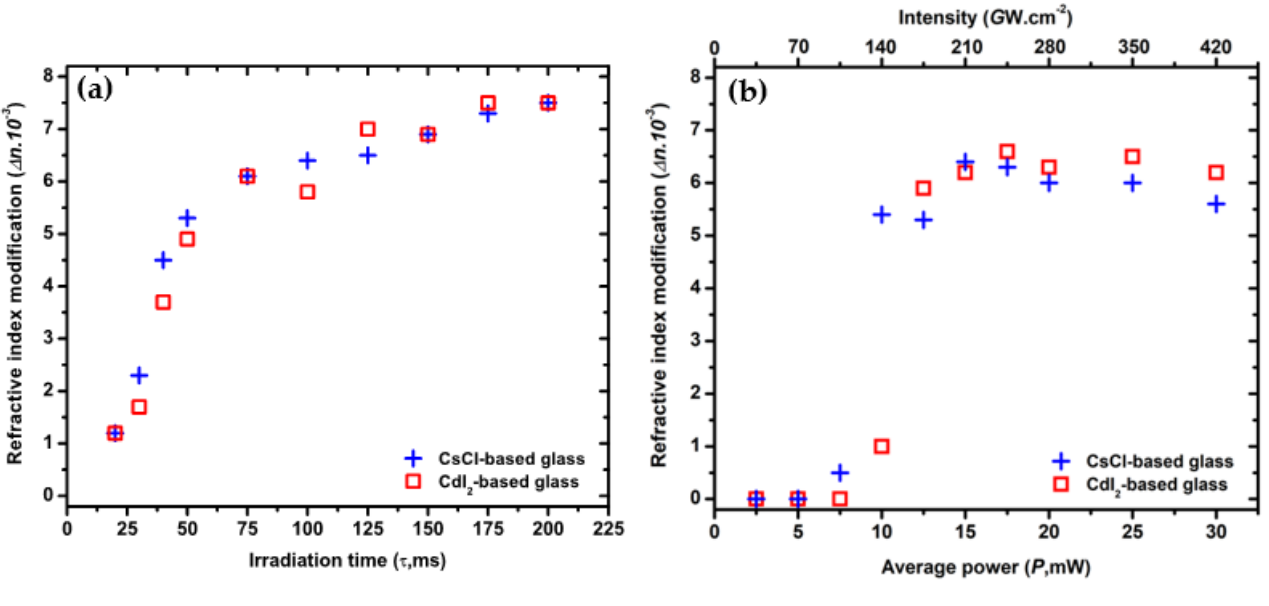
Figure 3. Evolution of the refractive index modification ( ∆ n) as a function of ( a ) the irradiation time ( τ ) at 20 mW and ( b ) the average power (P) and the corresponding intensity with τ = 100 ms in the selected glasses for the step-index fiber (CsCl — (blue cross) and CdI 2 — (red square) based glasses.